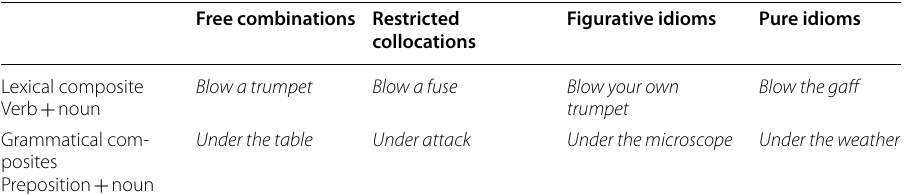
Table 1 Collocational continuum Free combinations Restricted Figurative idioms collocations